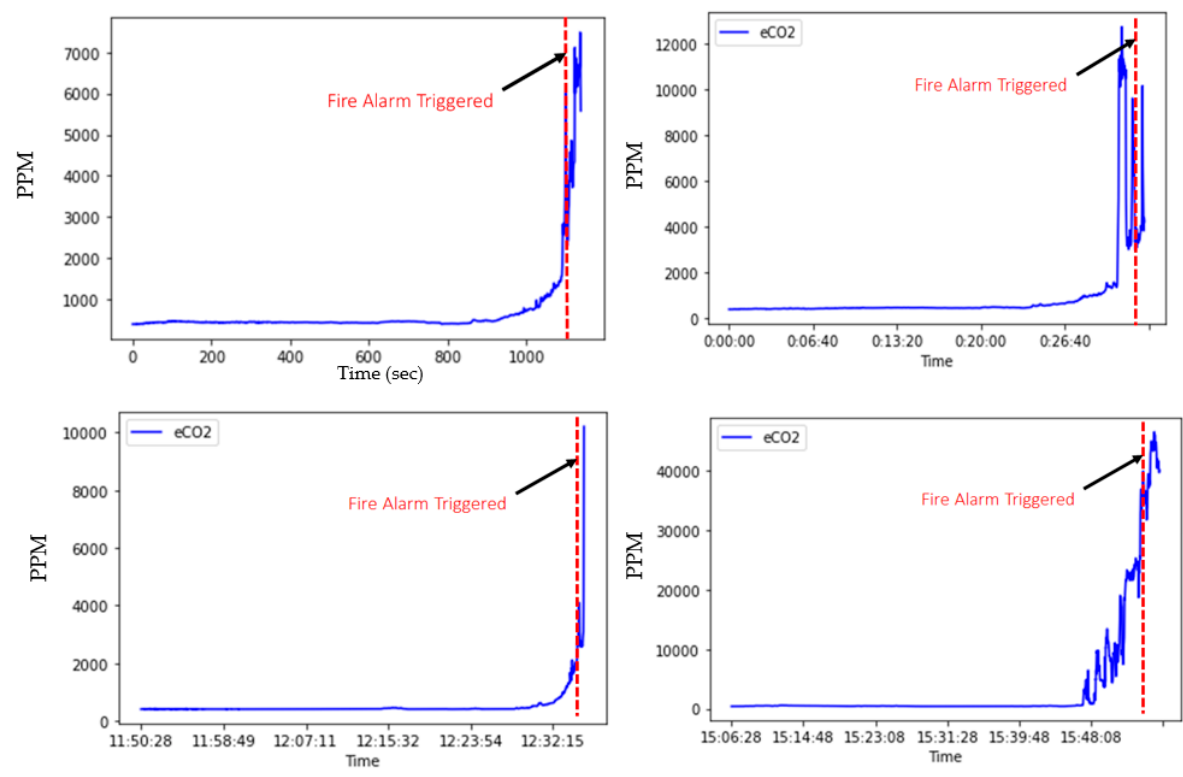
Figure 5. The eCO 2 reading measurements for four different experiments of electric fires.